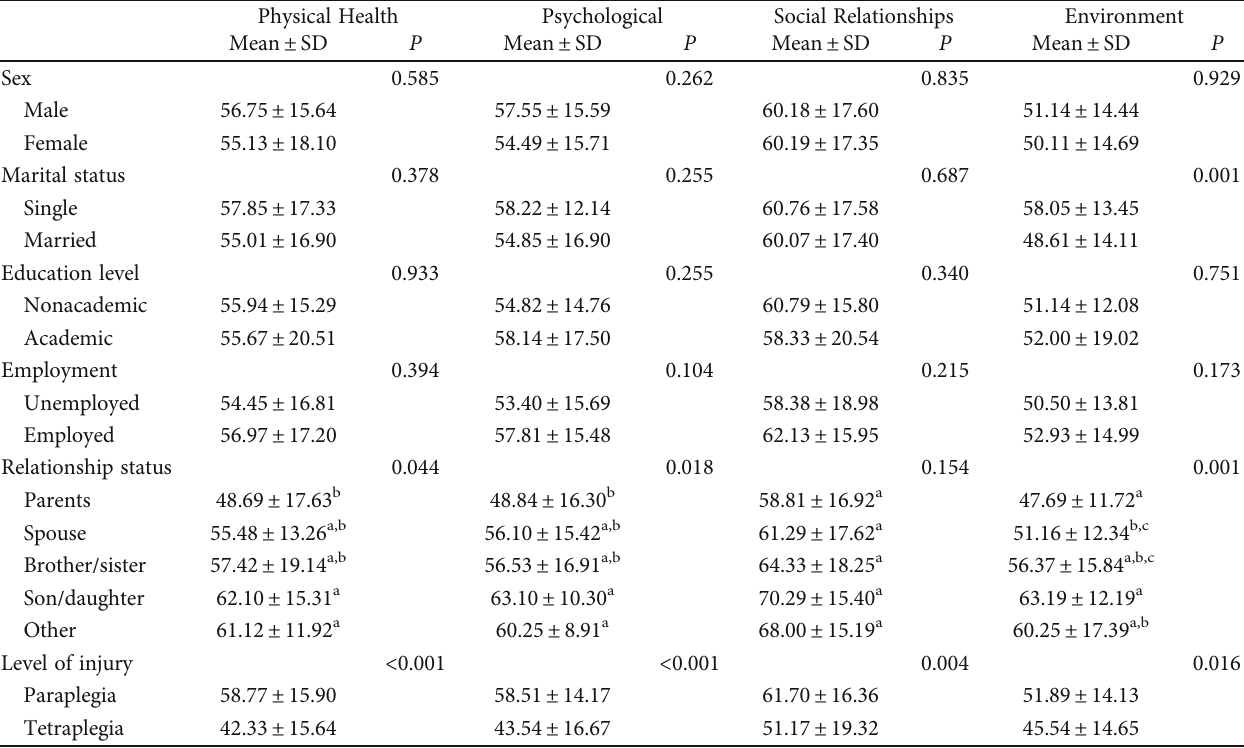
Table 2: Relationship of WHOQOL-BREF domains with demographic characteristics in caregivers of people with SCI using univariate